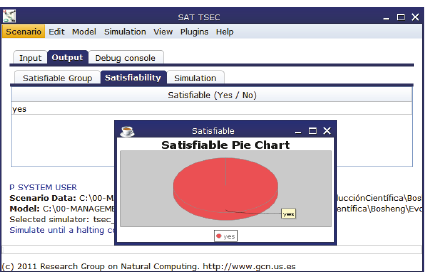
Figure 5: MeCoSim output for end